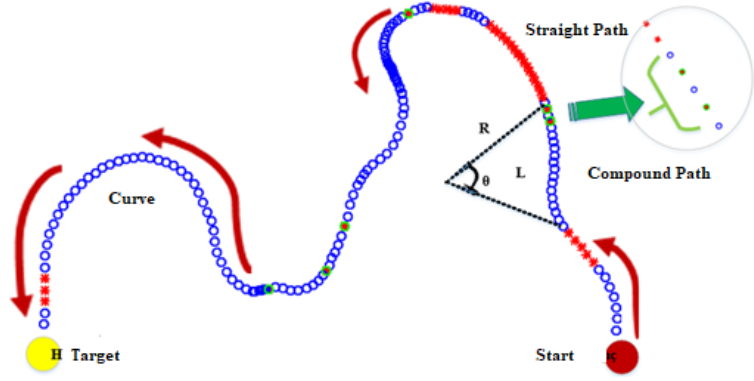
Figure 12. Detection and smoothing of segments of the road.